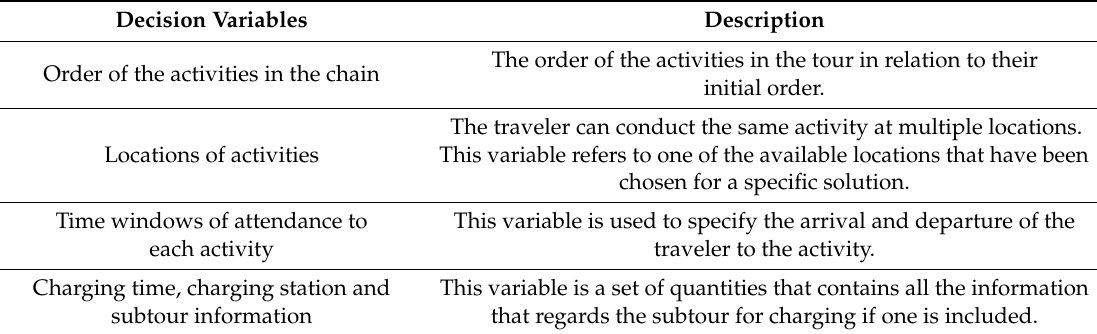
Table 4. Decision variables of DACO-EV.